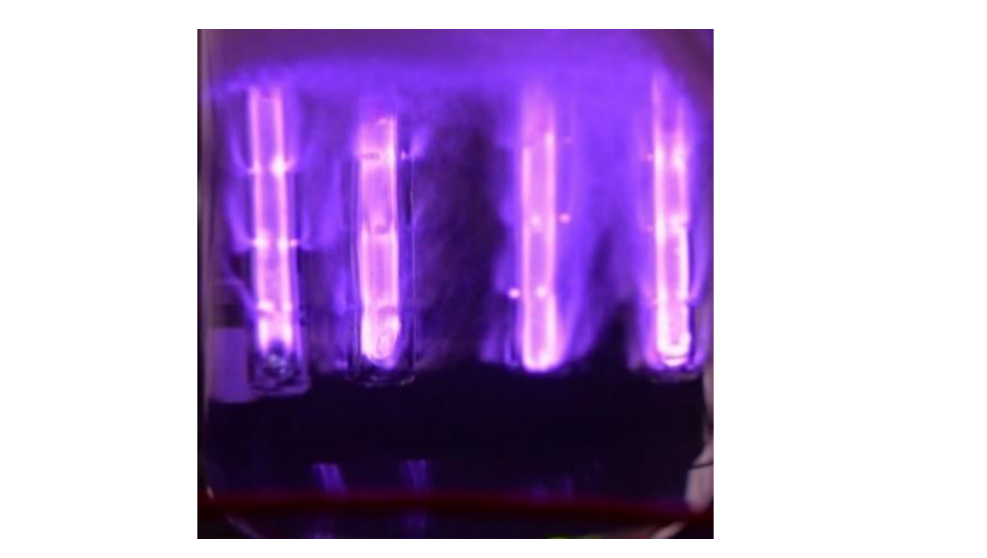
6 of 15 Figure 4. Discharges in the tap water at different applied voltages (Pictures taken by Nikon D750,